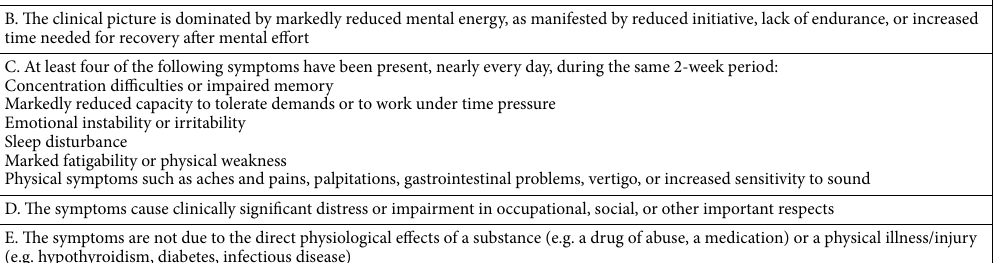
Table 1. Criteria for stress-induced exhaustion disorder according to the Swedish National Board of Health and Welfare and Swedish version of the International Classification of Diseases, 10th edition (code F-43.8). Criteria A through E must be fulfilled to diagnose stress-induced exhaustion